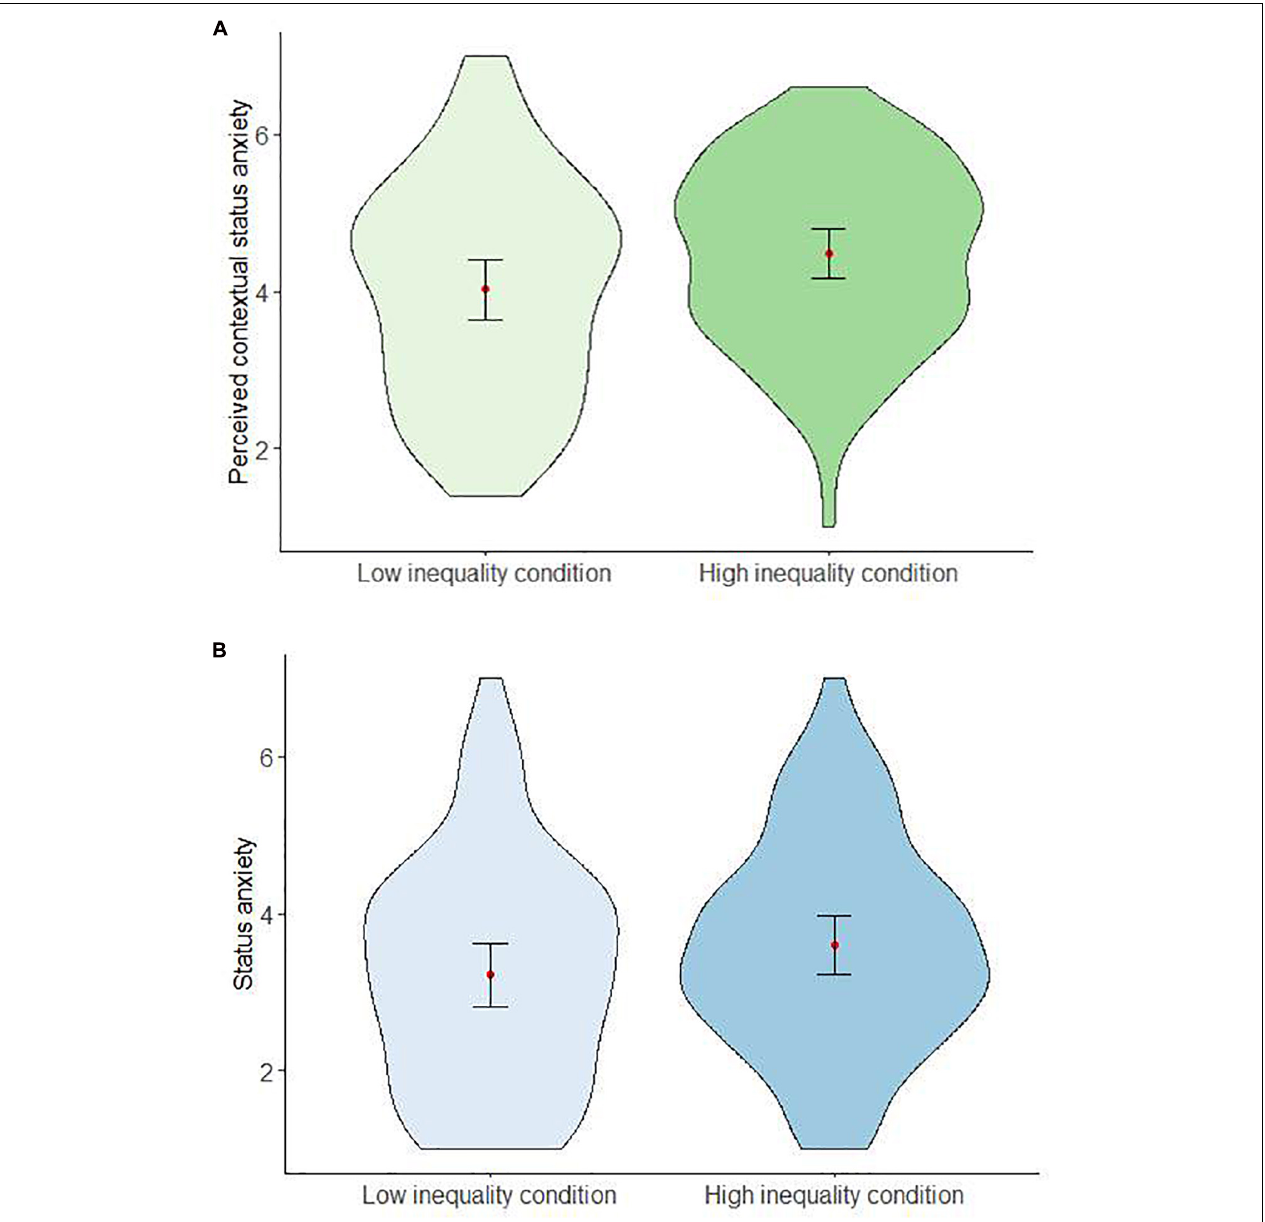
FIGURE 2 | Effects of perceived economic inequality condition on perceived contextual status anxiety (A) and participants’ status anxiety (B) in study